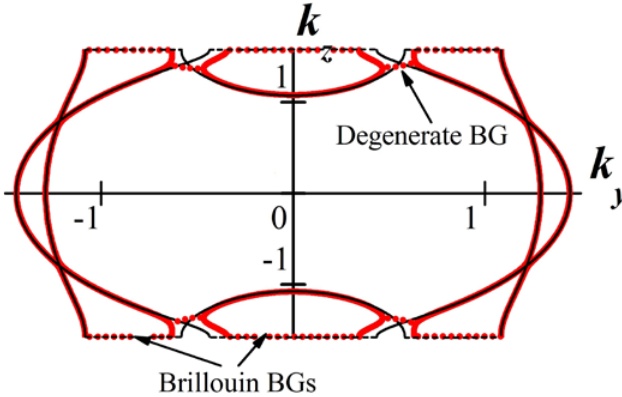
Figure 3. Isofrequency curves for magnetophotonic crystal with two layers of the same thickness d in a period, .